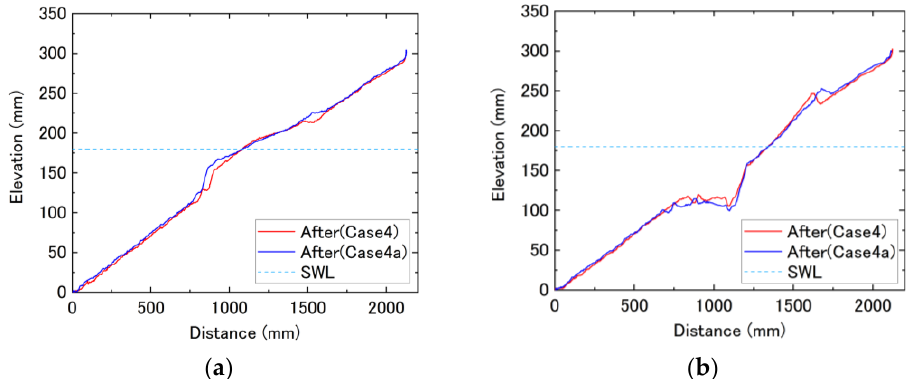
Figure 9. Topographical changes before and after the experiment: measurement of ( a ) cross-section 1 and ( b ) cross-section 2 of case 4a.